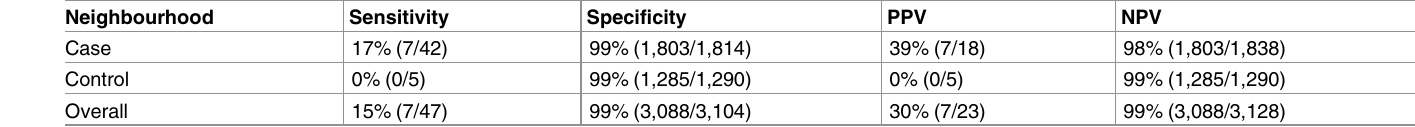
Table 4. Performanceof RDTs using LAMP as gold standard in caseand control